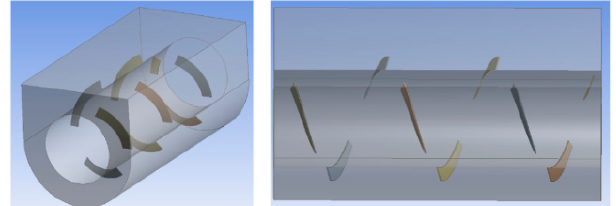
Figure 12. Blade gaps.